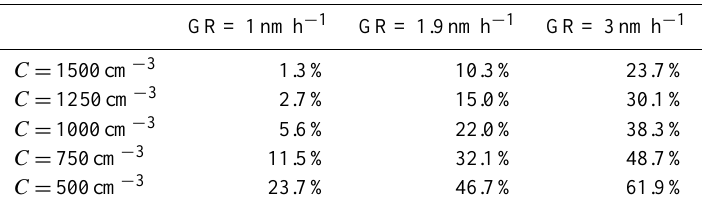
Table 1. Fractions of particles that remain charged as particles nucleated on ions at d = 1 . 5nm grow to d = 2nm at different particle growth rates (GR’s) and concentrations of small ions ( C